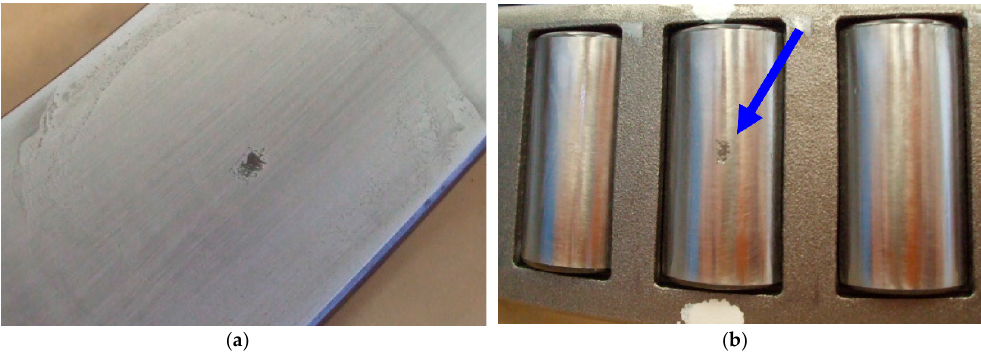
Table 1. Parameters of bearing BG3 ‐ GP5.